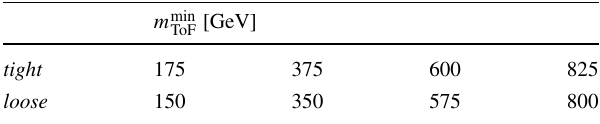
Table 9 Definition of the signal regions implemented in